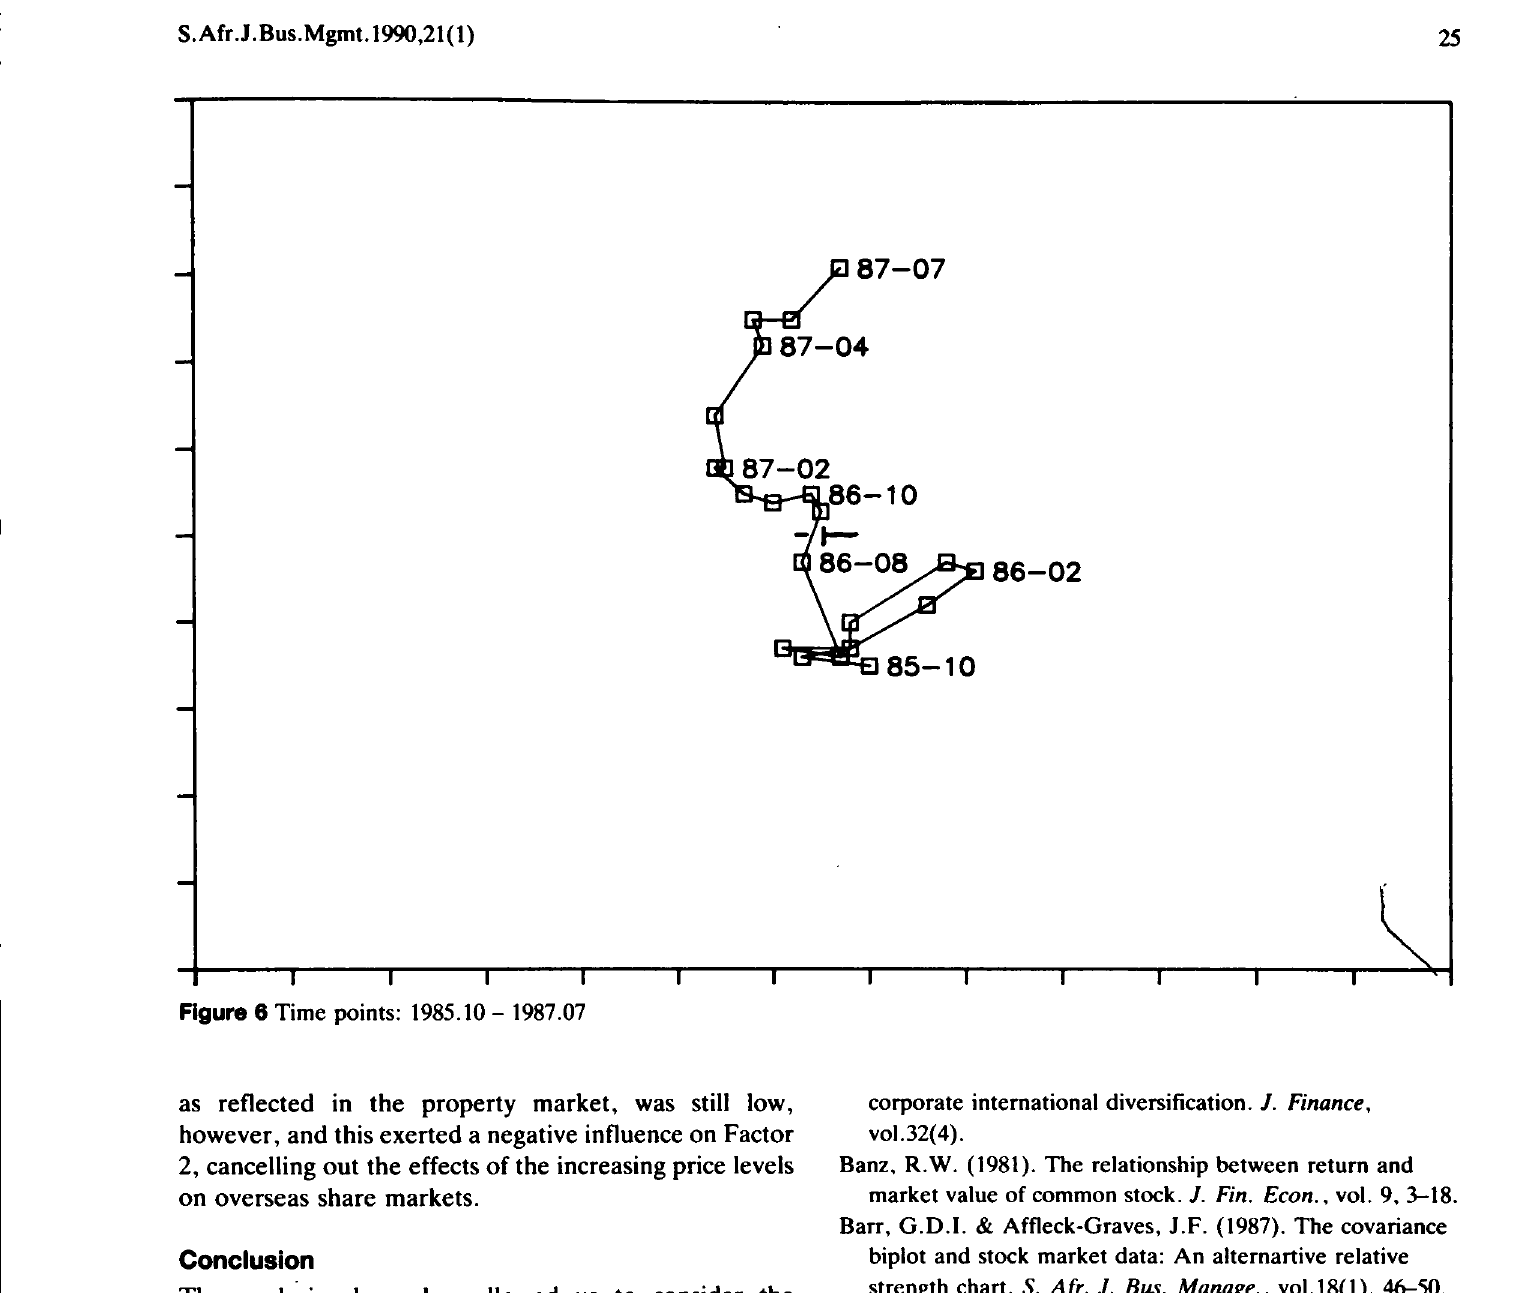
Figure 6 Time points: 1985.10 -